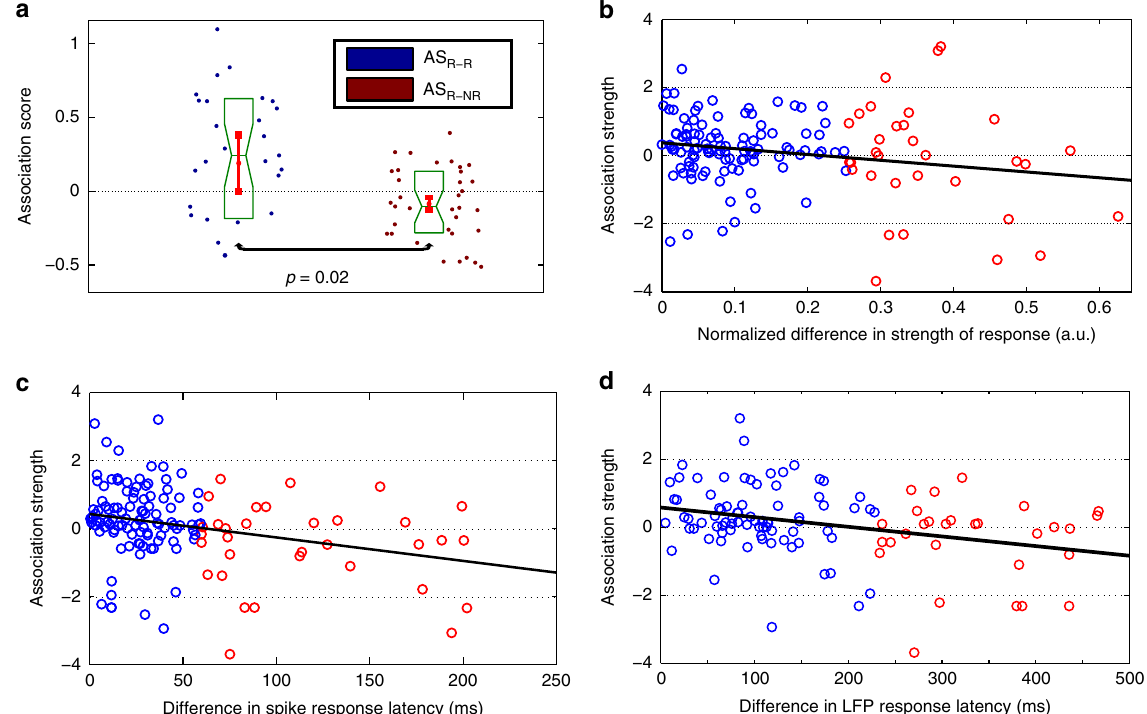
Fig. 6 Neural responses are more similar when the stimuli are associated. a Web-based mean association scores for multi-responsive units on stimulus pairs where both stimuli were responsive (AS R – R ), or one was responsive and the other one not (AS R – NR ). Response-eliciting pairs have a signi fi cantly larger association score ( n = 35, one-sided paired sign test, p = 0.02). Each dot represents a multi-responsive unit. Mean ± standard error of the mean are shown in red, whereas boxplots are in green (center line, median; box limits, upper and lower quartiles; notch limits, (1.57 × interquartile range)/sqrt( n )). b Association score as a function of the normalized difference in the response strength. Both quantities were signi fi cantly correlated ( n = 139, Pearson correlation, r = − 0.2, p = 0.019). The pairs representing the 25% with the largest differences are shown in red. c Same as b for the spike latency difference ( n = 139, Pearson correlation, r = − 0.28, p ~ 10 − 4 ). d Same as c for the LFP latency difference ( n = 93, Pearson correlation, r = − 0.22, p =